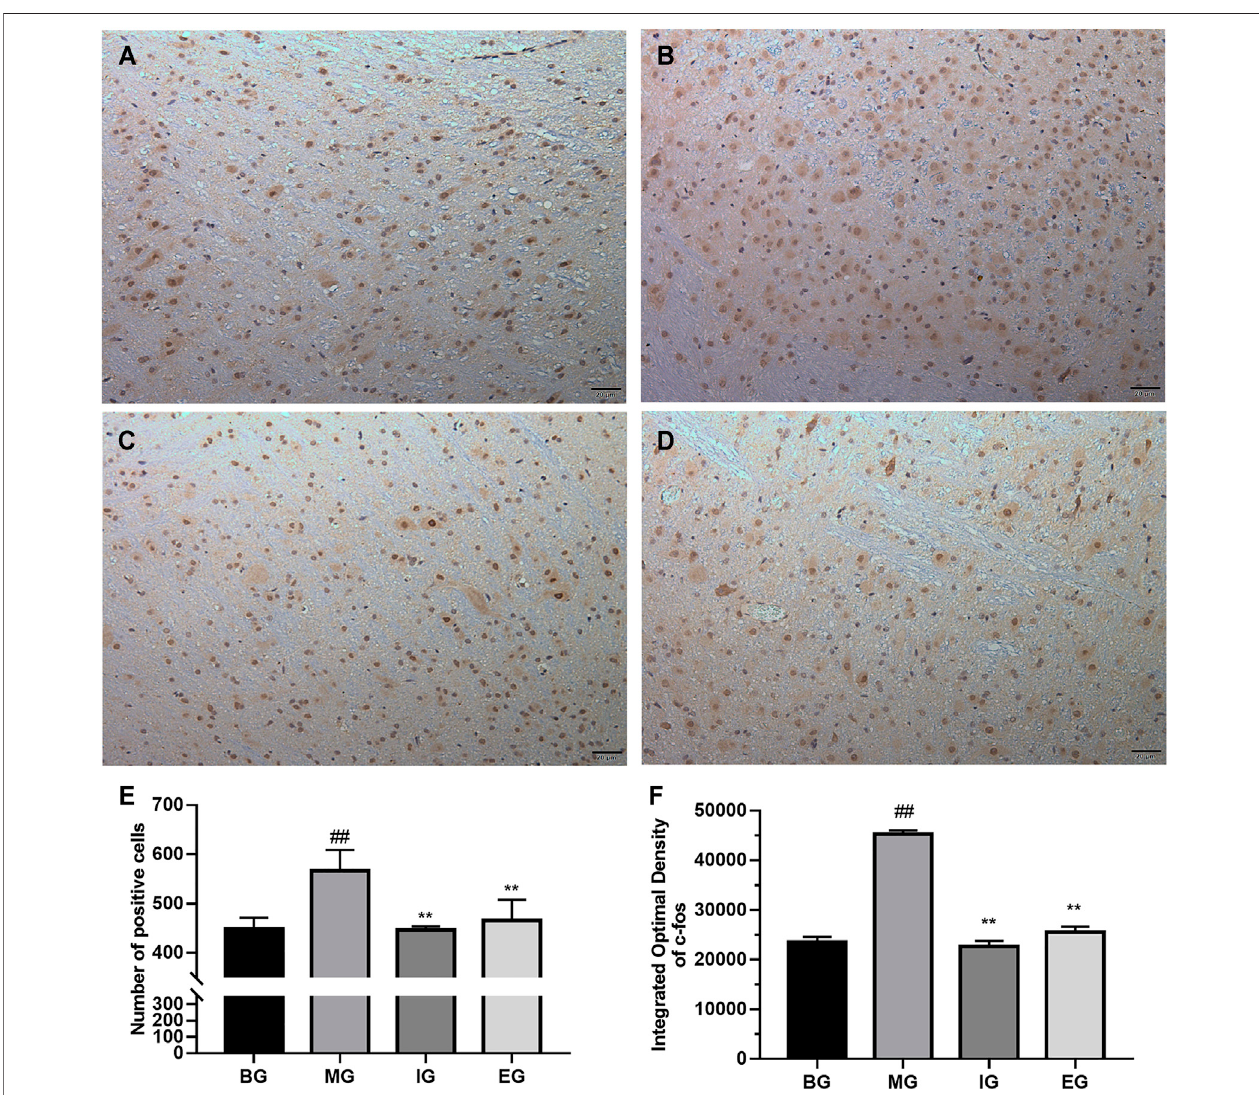
FIGURE5| Theresponseofemodin onc-Fosneurons inthebrainstem after NTGstimulation(sagittalcut). Immunohistochemistry photos: (A) BG, (B) MG, (C) IG, (D) EG; bar graph: (E) the number of c-Fos positive cells; (F) Integral Optical Density (IOD); taken photos under microscope at 200 × magni fi cation: Scale bar (cid:1) 20 μ m; values were represented as the mean ± SD ( n (cid:1) 5). ## p < 0.01 vs. the blank, ** p < 0.01 vs. the model.